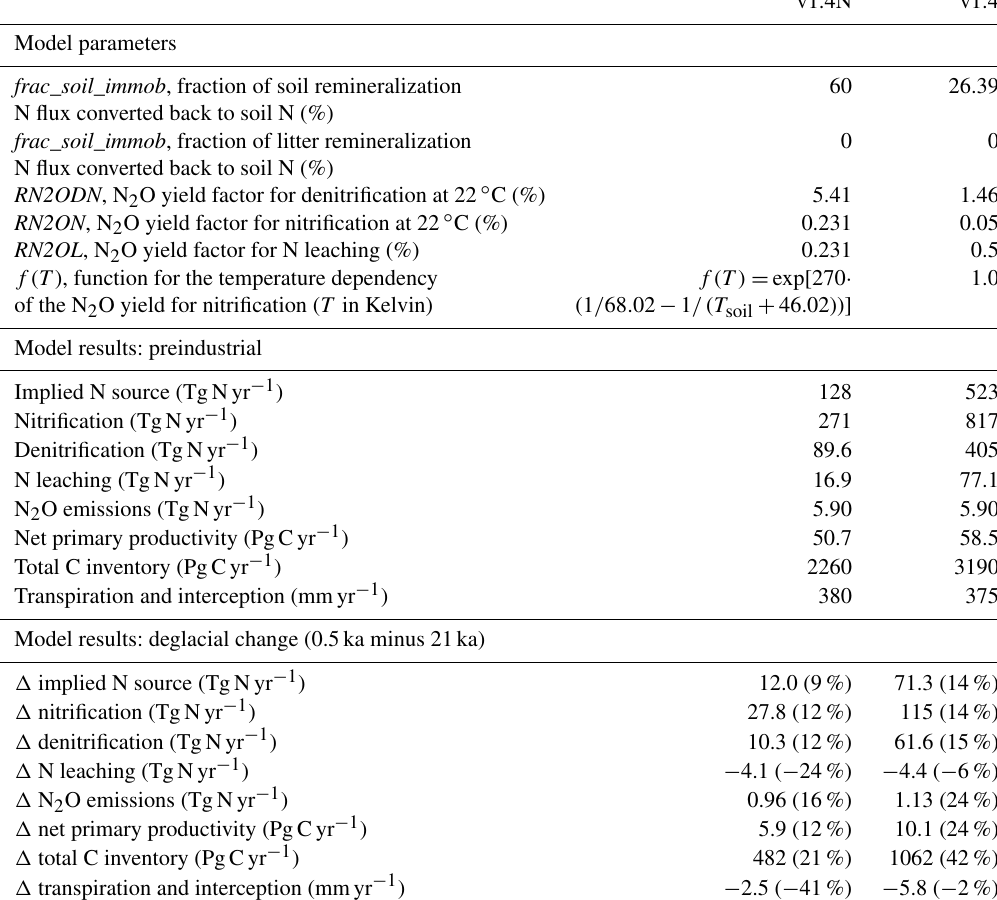
Table A1. Differences between LPX-Bern version v1.4N used in this study and the previous version (v1.4). Model results represent global average values. Percentage changes are given in parentheses and are relative to